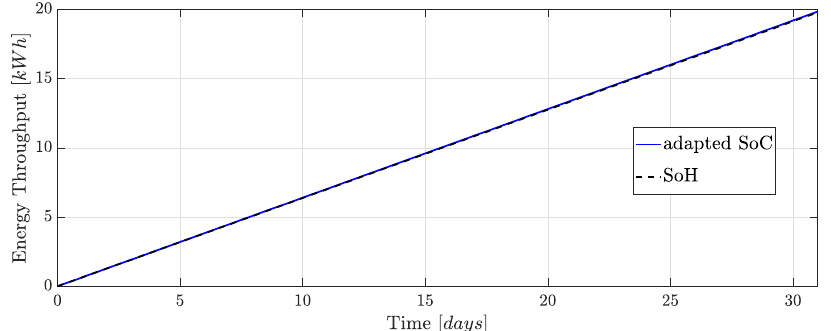
Figure 27. Energy Throughput: Case